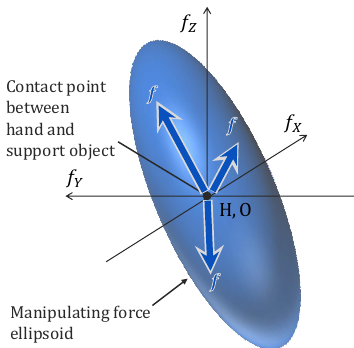
Figure 5. Overview of manipulating force